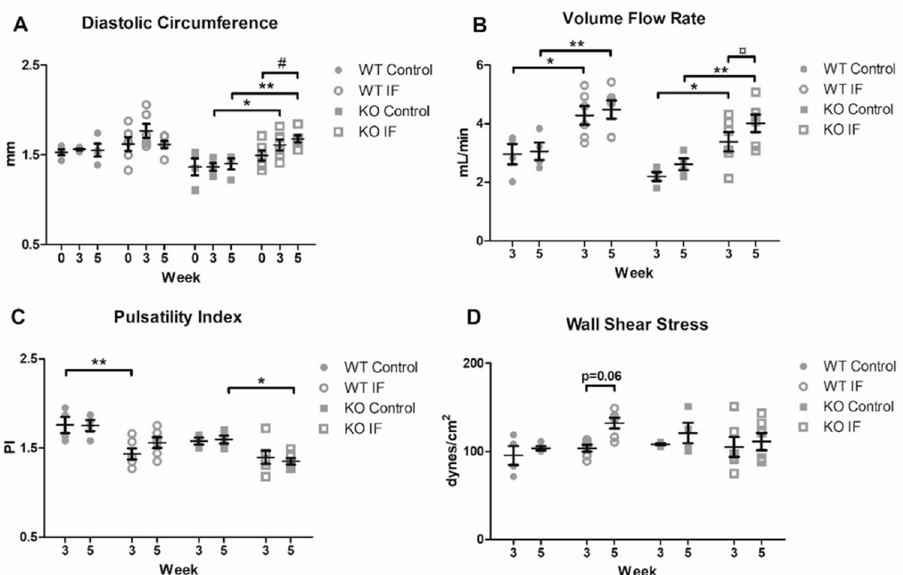
Figure 1. Morphology and hemodynamics of arteries exposed to increased flow measured by ultrasound biomicroscopy. Analysis of the right CCA revealed an increased flow-mediated ( A ) outward remodeling and ( B ) volume flow rate over time in the KO mice. A di ff erent pattern in ( C ) PI was seen between WT and KO mice. No significant di ff erence in ( D ) wall shear stress could be detected. 2-way ANOVA with Bonferroni Multiple Comparison test was used for comparing di ff erences between strain-specific mice under normal (WT n = 4, KO n = 4) and IF (WT n = 6, KO n = 6) conditions at the same time point, * p < 0.05 and ** p < 0.01. Wilcoxon signed rank test was used for comparing data within the same group from 3 to 5 weeks, ¤ p < 0.05, and 0 to 5 weeks, # p < 0.05. Data are expressed as mean ± standard error of mean. CCA = common carotid artery. IF = increased blood flow. KO = Pcsk6 − / − mice. PI = Pulsatility index. WT = C57Bl / 6J mice.